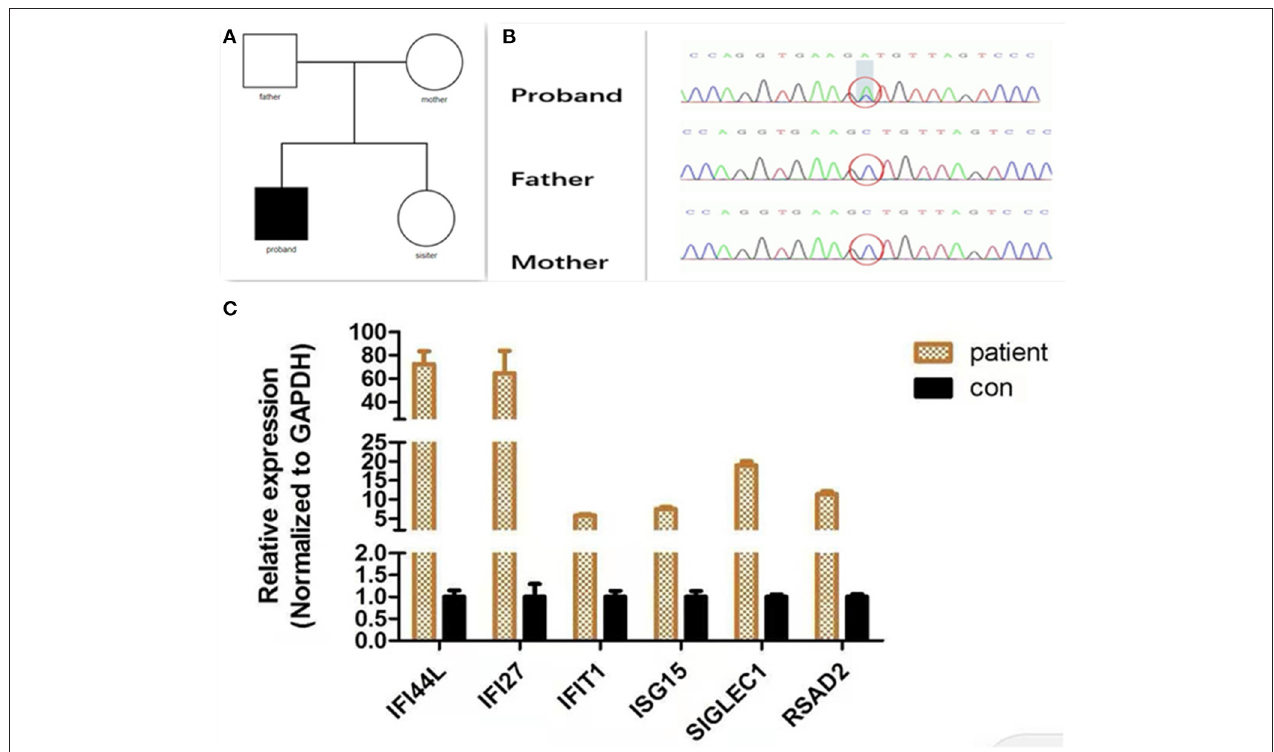
FIGURE 2 | Molecular findings. (A) Family tree. (B) A de novo IFIH1 mutation c.1465G > T (p.Ala489Ser) confirmed by Sanger sequencing. (C) Quantitative analysis of interferon-stimulated genes. The expression of interferon-stimulated genes ( IFI27 , IFIT1 , IFI44L , ISG15 , SIGLEC1 , and RSAD2 ) was analyzed by quantitative PCR. The relative expression of each interferon-stimulated gene in PBMCs (peripheral blood mononuclear cells) isolated from the patient was normalized to controls and represented as a mean and standard deviation. Control PBMCs were donated from a healthy individual who had been age- and gender-matched. All experiments were carried out in